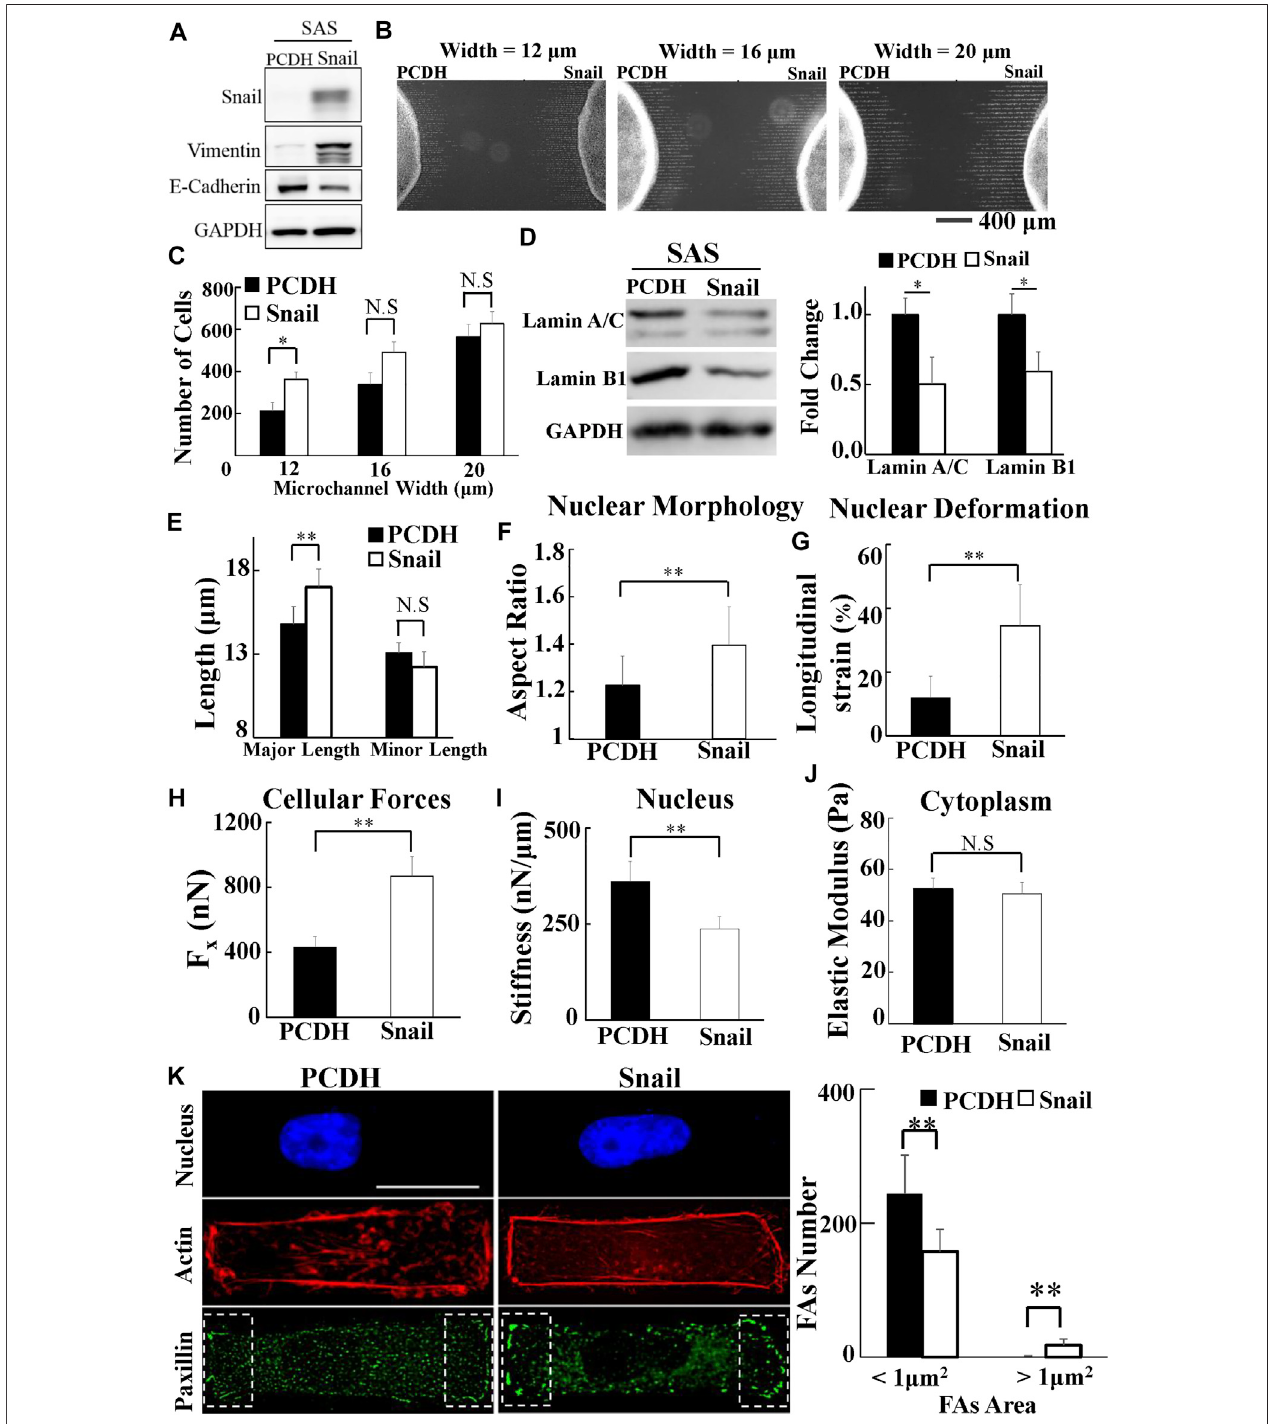
FIGURE5| TheeffectofSnailonthebiomolecularandbiomechanicalpropertiesofSAScells. (A) WesternblotofSnail,E-cadherin,andvimentinincontrol(PCDH) by transfecting PCDH-puro-ctrl and Snail-overexpressing SAS cells (SAS-Snail) by transfecting PCDH-puro-Snail plasmid, with GAPDH as a loading control. (B) The fl uorescence images of SAS-Snail and SAS cells, after invasion for 24 h from the access ports into the microchannels (with different widths of 12, 16, and 20 μ m). To visualize and count the number of cells in the microchannels, the cells nuclei were stained with Hoechst 33342. (C) Overexpression of Snail enhanced the invasion capabilityofSAScells inanarrow channel(12 μ m).Datarepresent mean± SD(n=3). (D) Overexpression ofSnail suppressed the expression oflaminA/C and B1. Left: westernblotoflaminA/CandB1incontrol(PCDH)andSnail-overexpressingSAScells(SAS-Snail).GAPDHwasusedasaloadingcontrol.Right:foldchangeoflaminA/